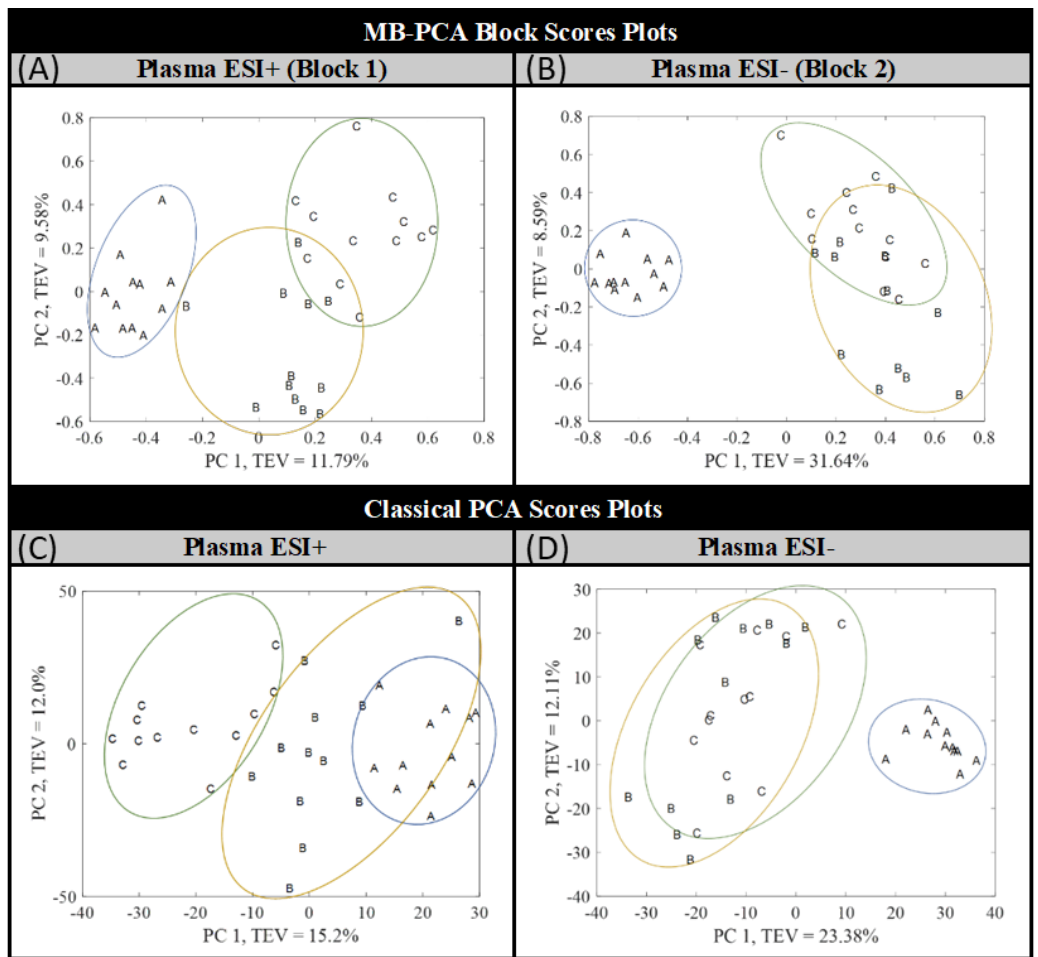
Figure 4. Upper score plots: Block score plot of the blocks ( A ) Plasma ESI+ and ( B ) Plasma ESI − of the MB-PCA model. Lower score plots : Score plot of classical PCA for the autoscaled matrix of ( C ) Plasma ESI+ and ( D ) Plasma ESI − . Piglet groups: newborns (A), infants (B), and children (C). TEV = total explained variance.